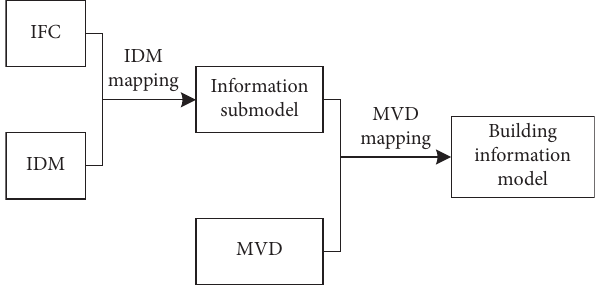
Figure 4: Data delivery